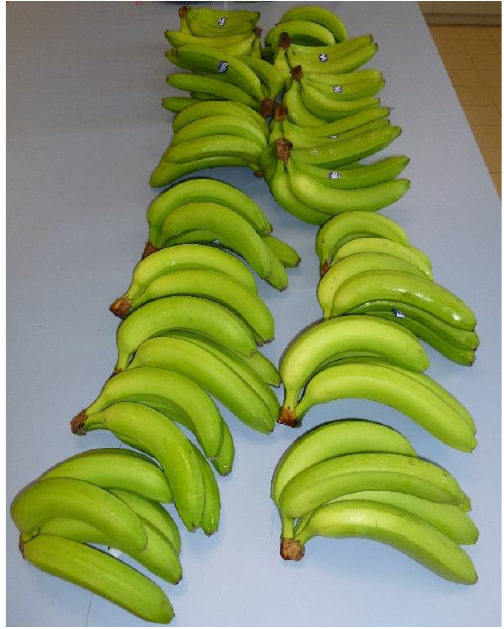
Figure 1. Samples of untreated green- ripe ‘Cavendish’ bananas ( Musa cavendishii L.), prepared for sorting and grouping.